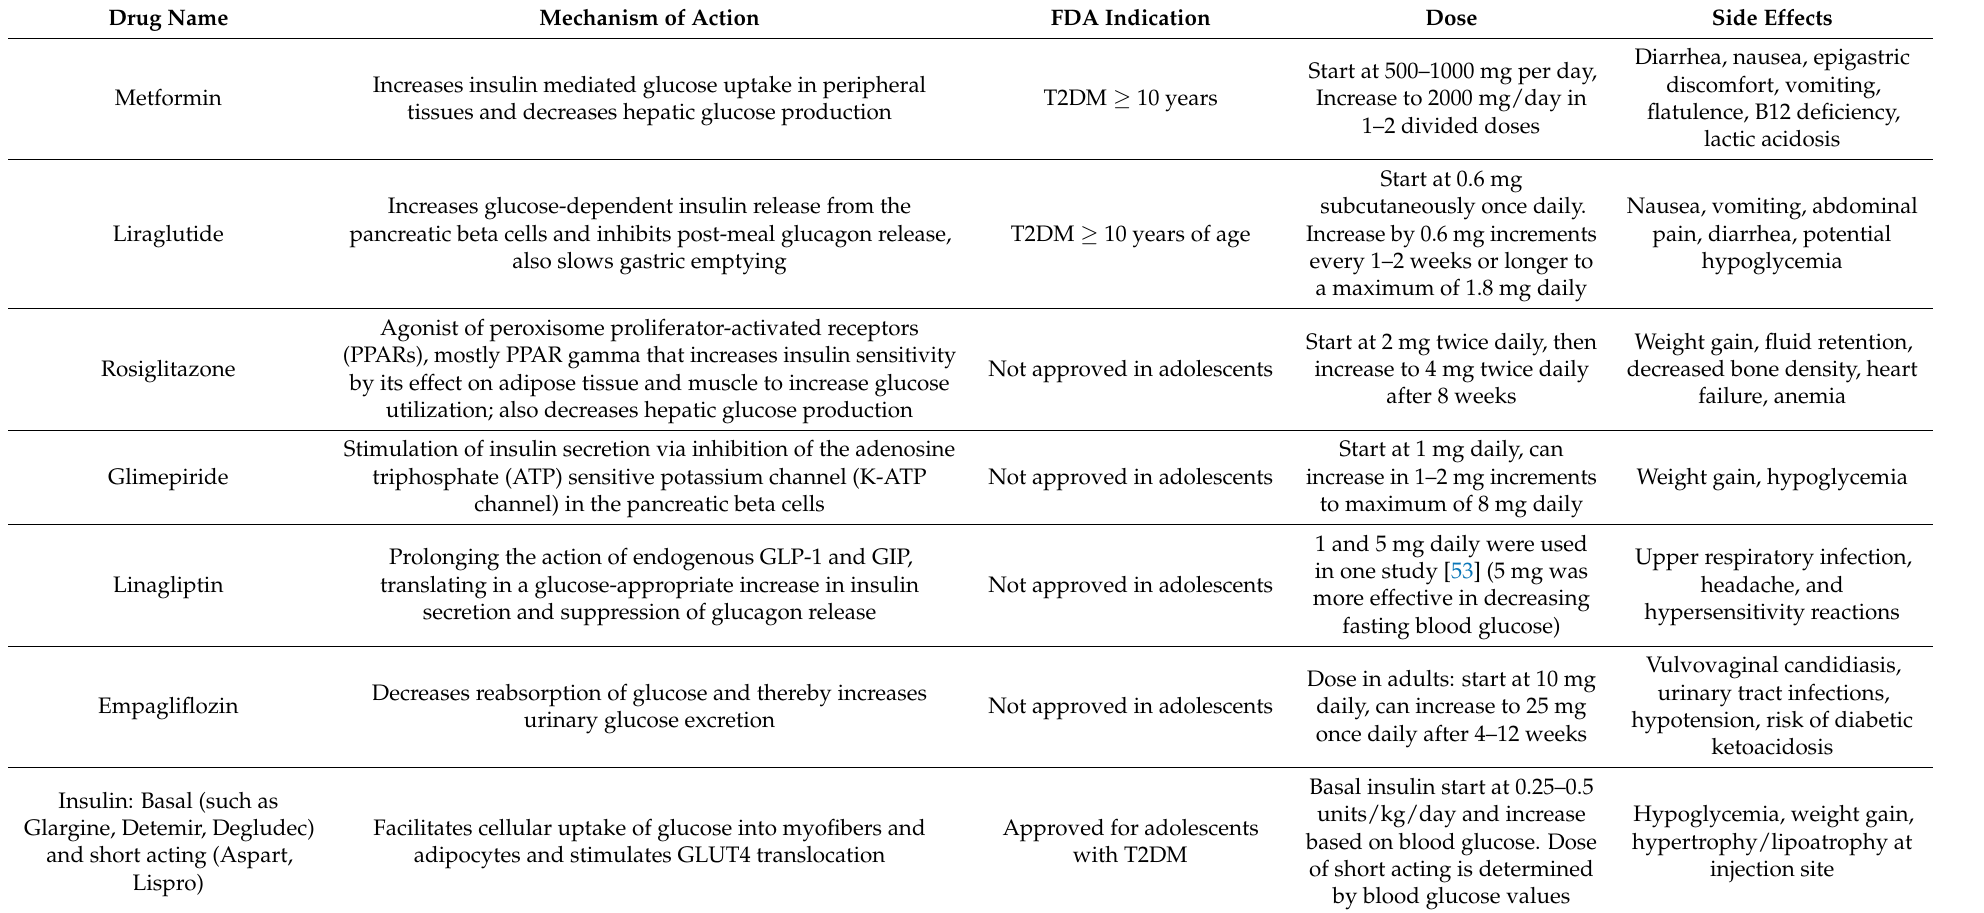
Table 1. Pharmacologic agents (Food and Drug Administration (FDA)-approved and off-label treatments for type 2 diabetes in